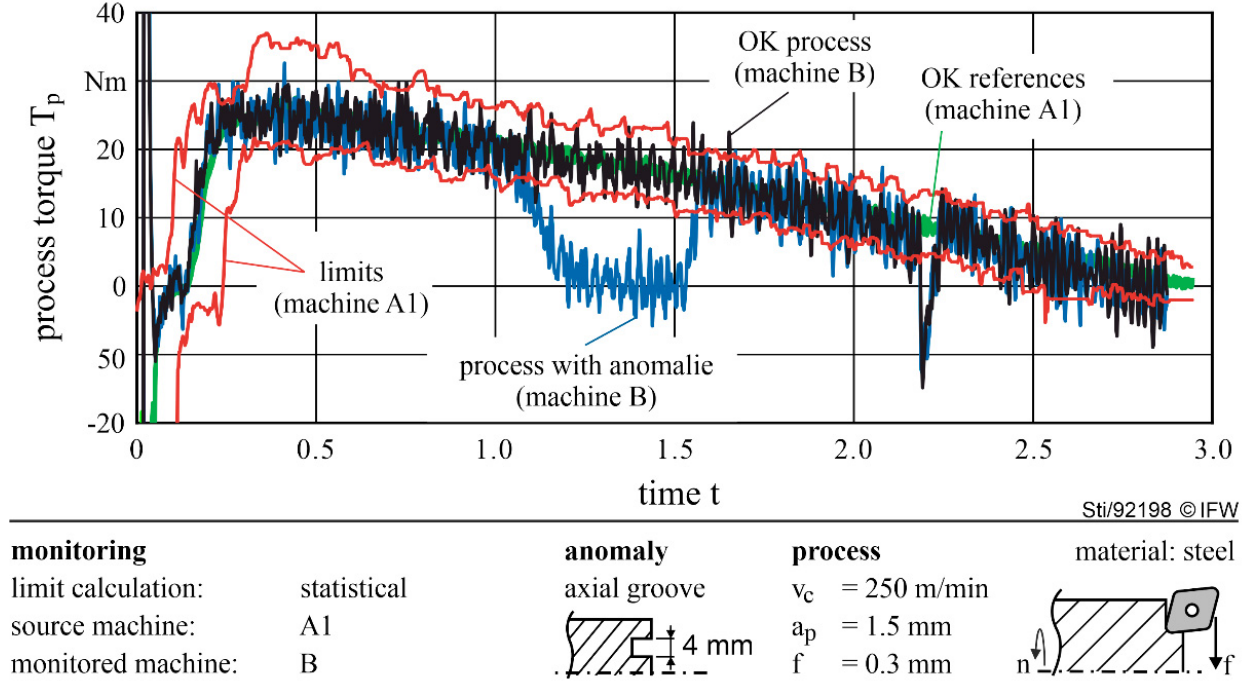
Figure 7. Monitoring of an OK-process and a process with anomaly using statistical monitoring limits calculated from another machine. The difference in signal noise impaired monitoring and caused false alarms.